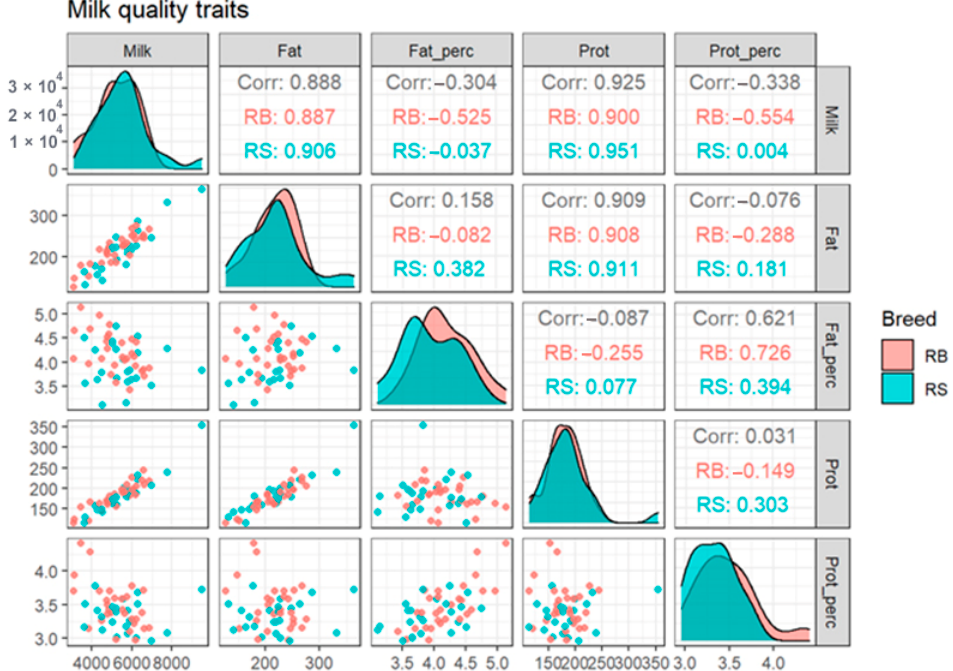
Figure 2. Scatterplots and correlations for the two breeds taken together and, individually, for each breed-specific population. The three values from each cell of the upper triangular portion of the figure represent the correlation between data points of pairs of phenotypes among the total population (RS + RB), and separately for the RB and RS breed-specific population, respectively. Corr, correlation; RB, Romanian Brown; RS, Romanian Spo tt ed.